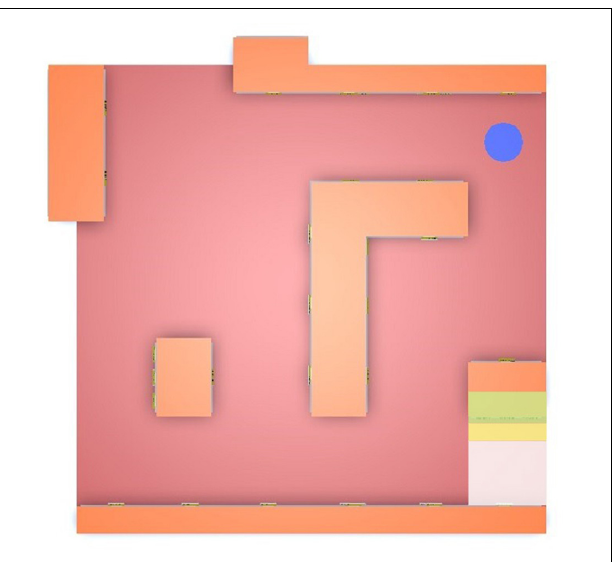
FIGURE 5 | Zenithal view of zones and areas of interest for Task 2. FIGURE 6 | Zenithal view of zones and areas of interest for Task